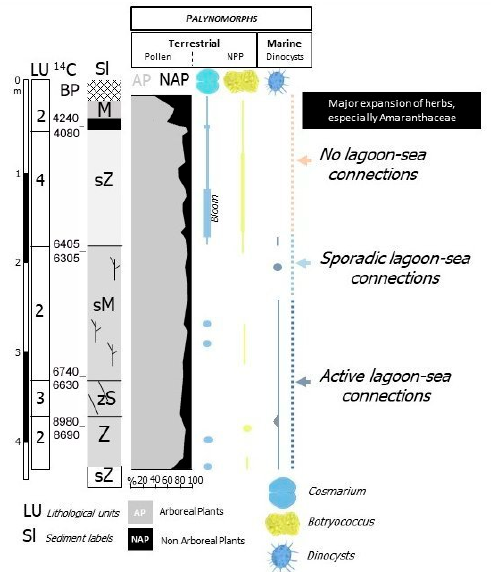
Figure 4. Summary of the palynological evidence from BU1 core. For the legend of sediment labels see Figure 3a. Age calibrated year BP.